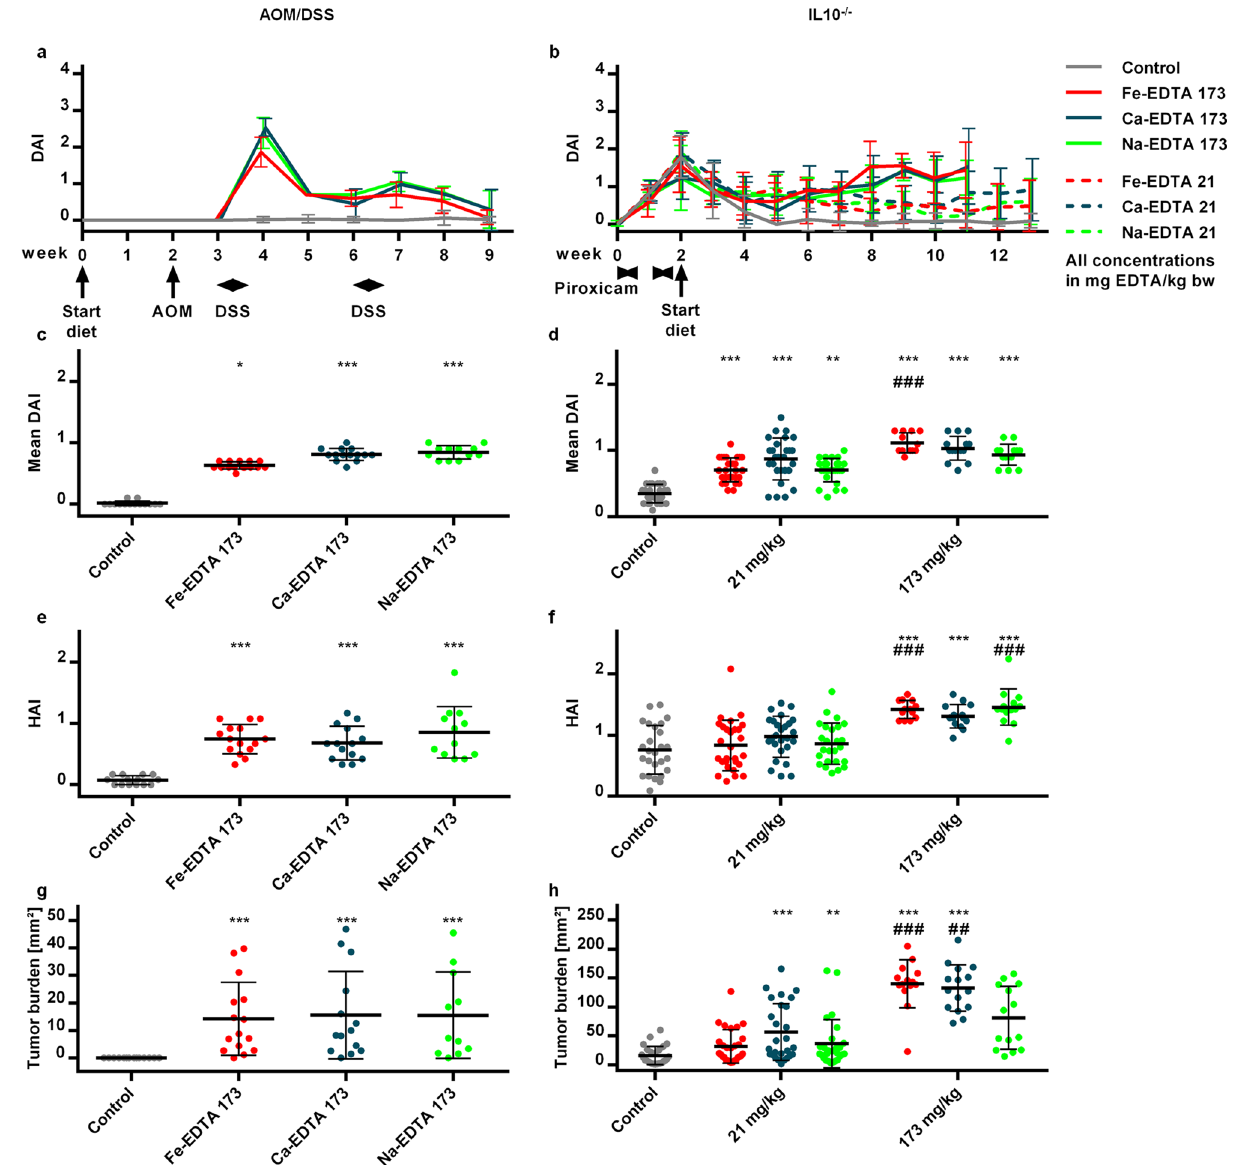
Figure 2. EDTA compounds enhance colitis activity and colorectal carcinogenesis in the AOM/DSS and IL10 −/− models. (a , b) Time course of the clinical disease activity index DAI in the AOM/DSS ( a ) and IL10 −/− ( b ) model. The timeline of experimental interventions is shown on the x axis. ( c,d ) Mean DAI over the full time course ((i.e. weeks 3–9 for AOM/DSS ( c ) and weeks 2–11 for IL10 −/− ( d )); ( e , f ) Histological activity index (HAI) for AOM/DSS ( e ) or IL10 −/− ( f ); ( g,h ) Tumour burden (i.e., total tumour area per mouse) for AOM/DSS ( g ) or IL10 −/− ( h ). Error bars represent standard deviations. Asterisks (*: p < 0.05; **: p < 0.01; ***: p < 0.001) denote statistically significant results compared to the control group; hashtags (#: p < 0.05; ##: p < 0.01; ###: p < 0.001) mark significant differences between both EDTA compound